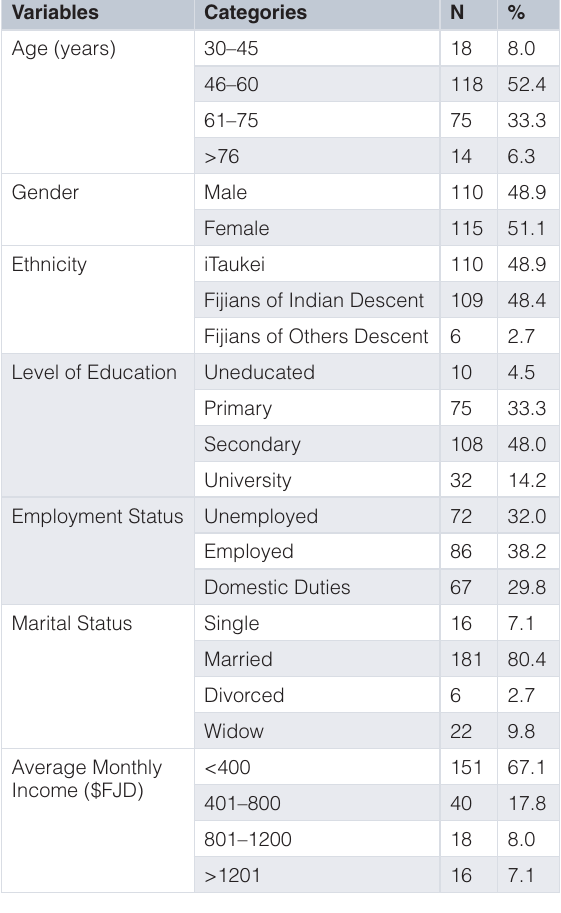
Table 1. Demographic Characteristics of Participants (n = 225).